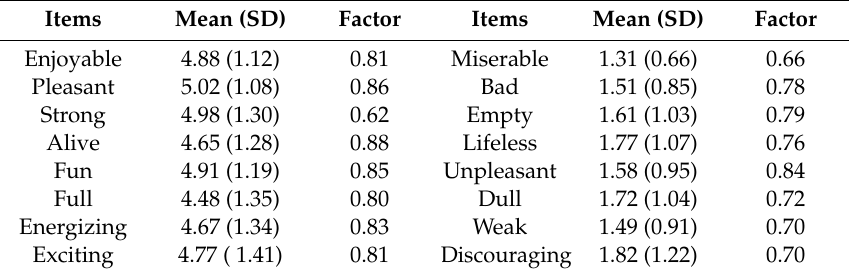
Table 1. Descriptive Statistics and Exploratory Factor Loadings for the student